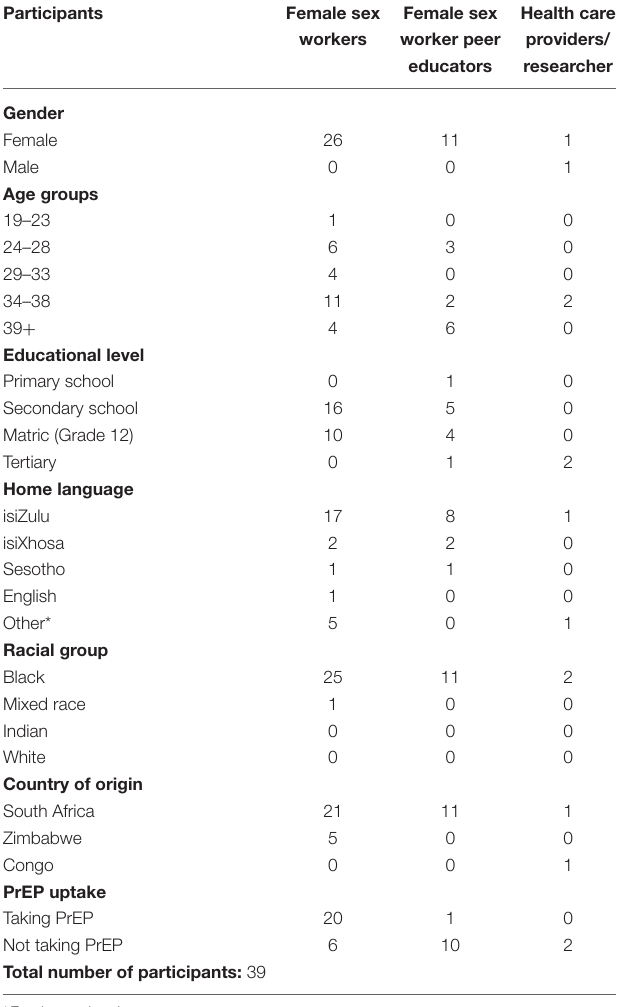
TABLE 1 | Sociodemographic background of participants.